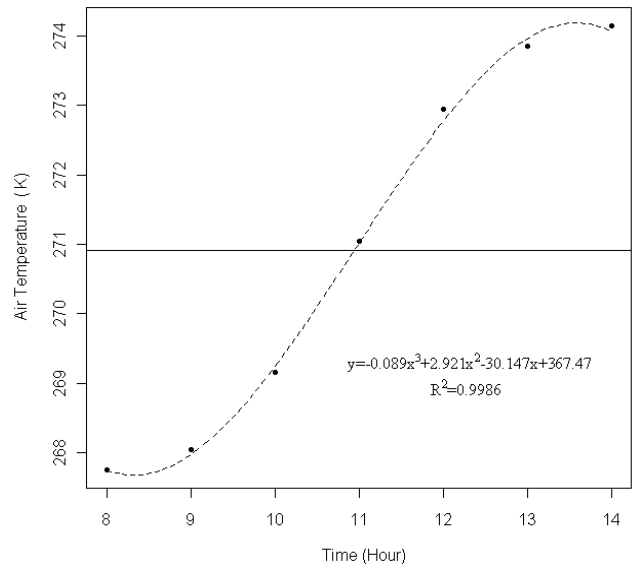
Figure 4. Air temperature between 8 AM and 2 PM at Whitehorse on 20 October 2008. The dashed line indicates the polynomial trend line and the solid line (270.9 K) indicates the average air temperature between 12:01 AM and 11:59 PM on 20 October 2008. Hour on the x axis indicates time in